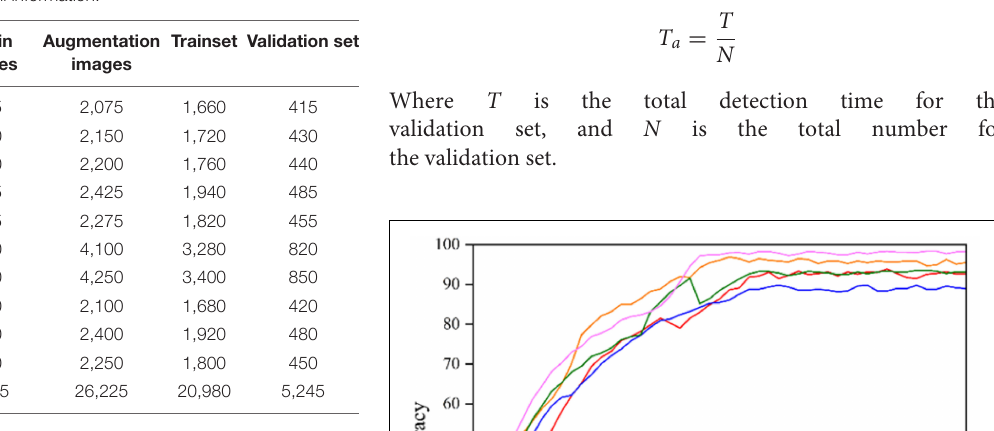
TABLE 2 | Crop pest dataset detail information.